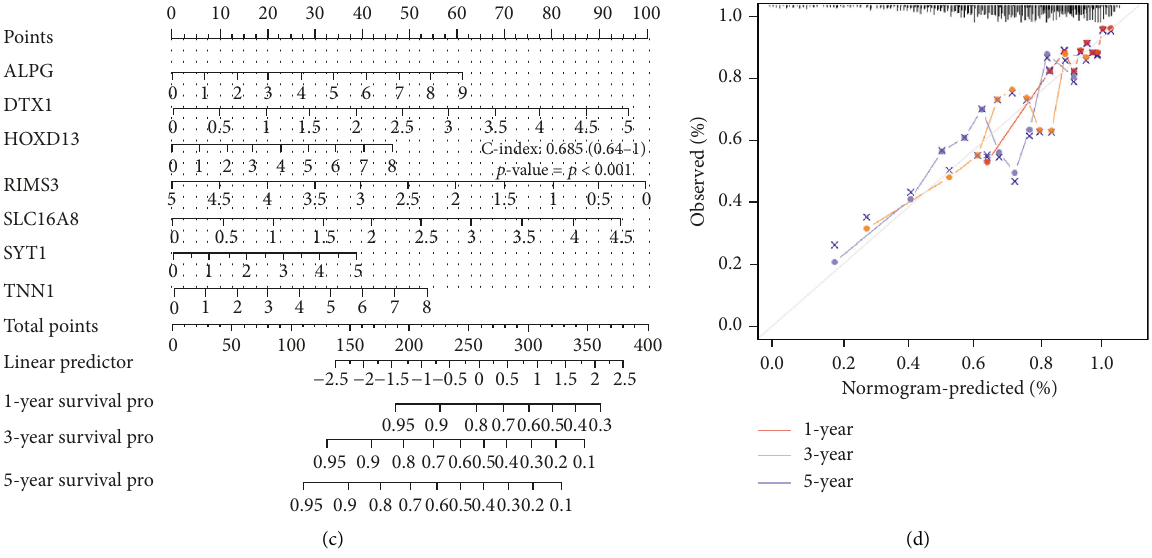
Figure 5: The prognostic nomogram with prognostic mRNAs. (a)-(b) Univariate and multivariate Cox regression analyses. (c) The prognostic nomogram with prognostic mRNAs. (d) The dotted line is the ideal calibration curve of the